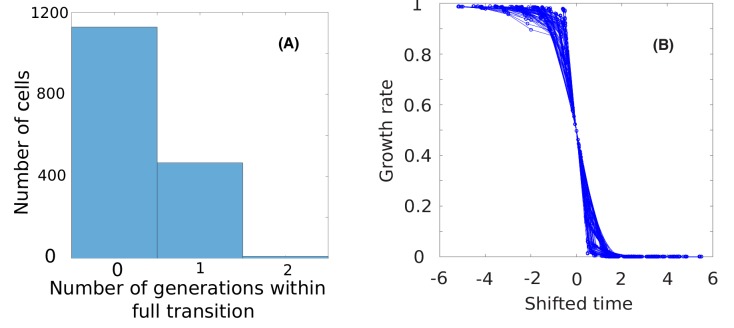
Statistics of cells undergoing growth transition.(A) The histogram of the number of generations of the cells that experienced high-to-low growth rate transition.(B) Curves of growth rates vs. shifted time for 100 cells randomly selected from those 80% cells.